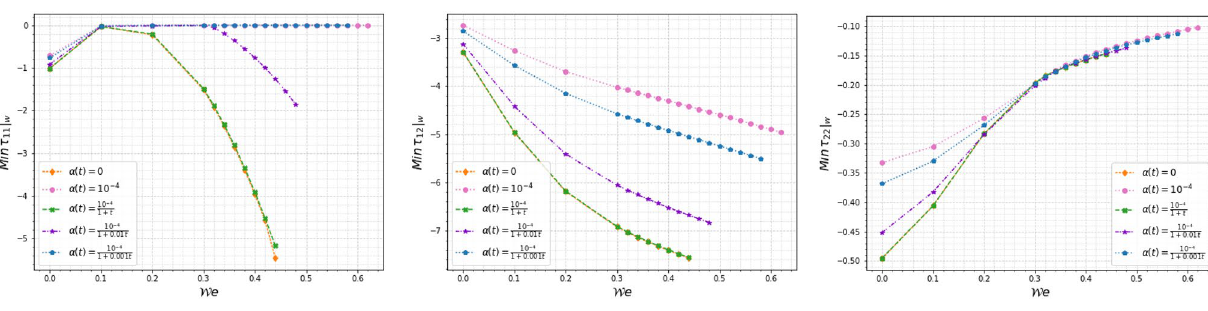
Fig. 8 Minimum values of the extra stress tensor along the channel wall for different setting of the parameter 𝜀 in the diffusion coefficient 𝛼 ( t ) = 10 − 4 , depending on the Weissenberg number W e 1 + 𝜀 t